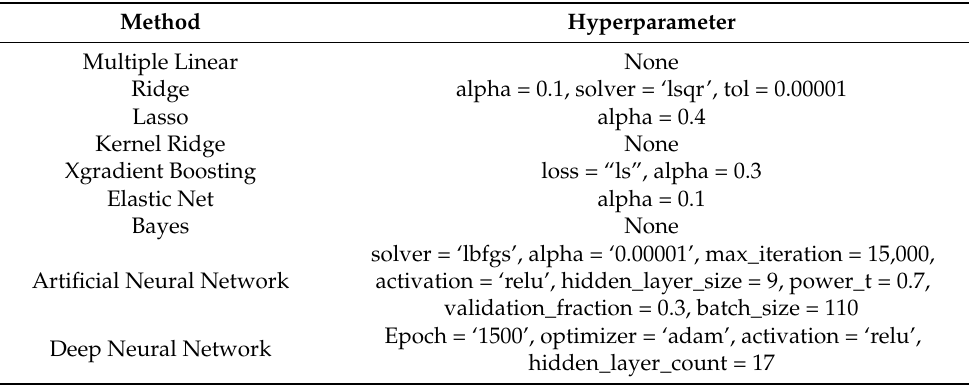
Table 2. Tuned hyperparameters.